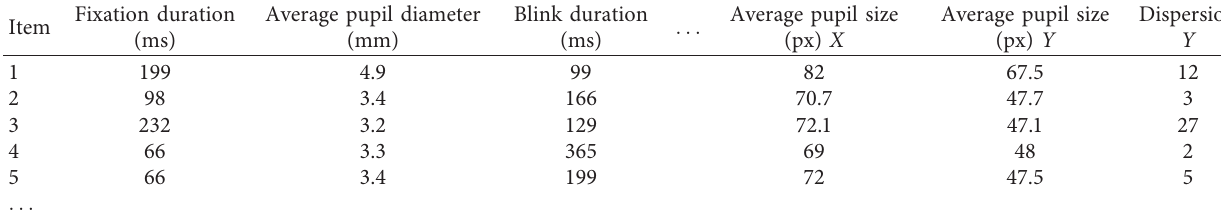
Table 1: Eye movement data during the second tunnel.